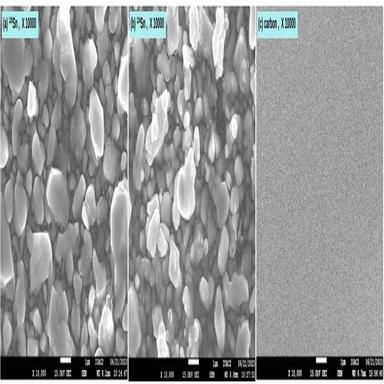
SEM images of enriched (a) 120Sn, (b) 124Sn targets (c) carbon film at a magnification of 10K.